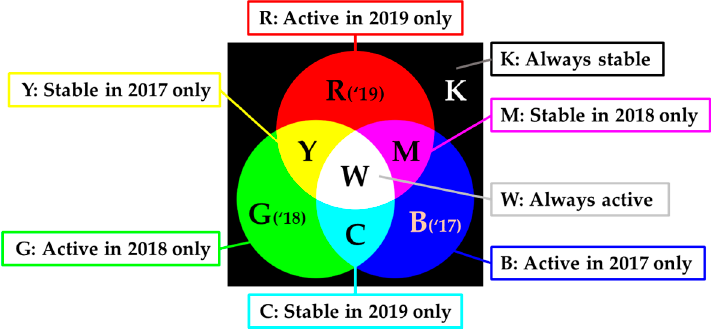
Figure 8. A pseudo-color scheme of surface activity by the RGB composite of annually averaged NDAI images (R: 2019, G: 2018, and B: 2017). Table 1. Annual surface activities and the meaning of the pseudo-color of the RGB composite of annually averaged NDAI images. Activity Pseudo-Color Meaning of Color B: 2017